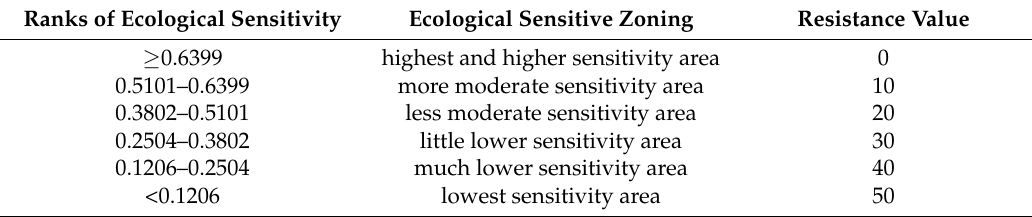
Table 4. Resistance values of the resistance surface in Zhengzhou.